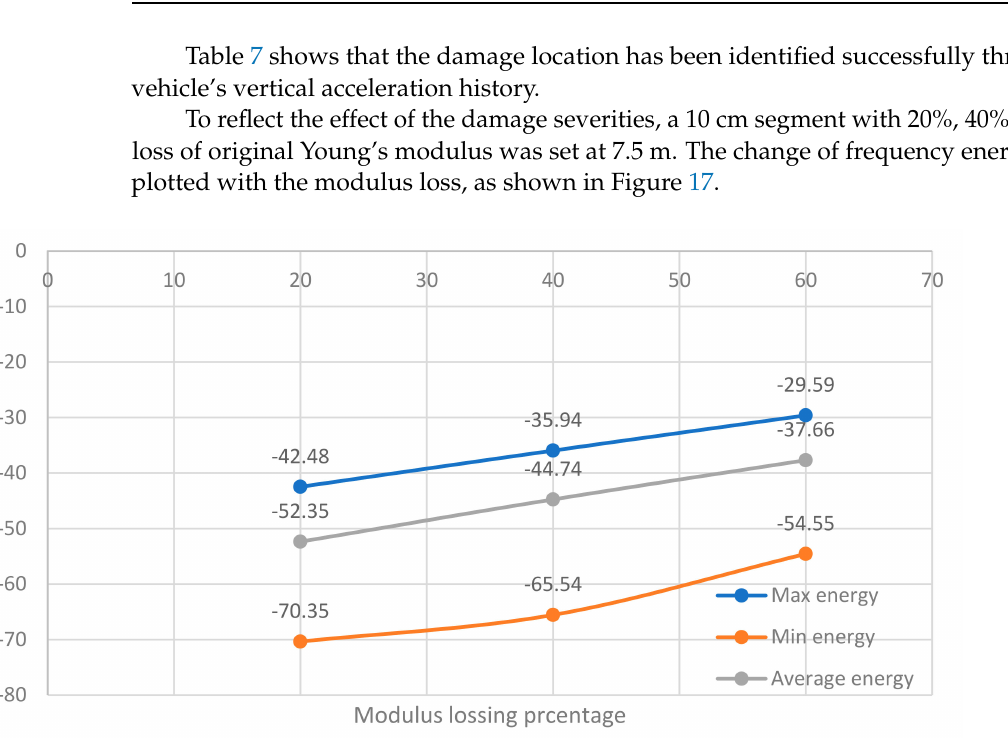
Figure 17. STFT energy results for different damage